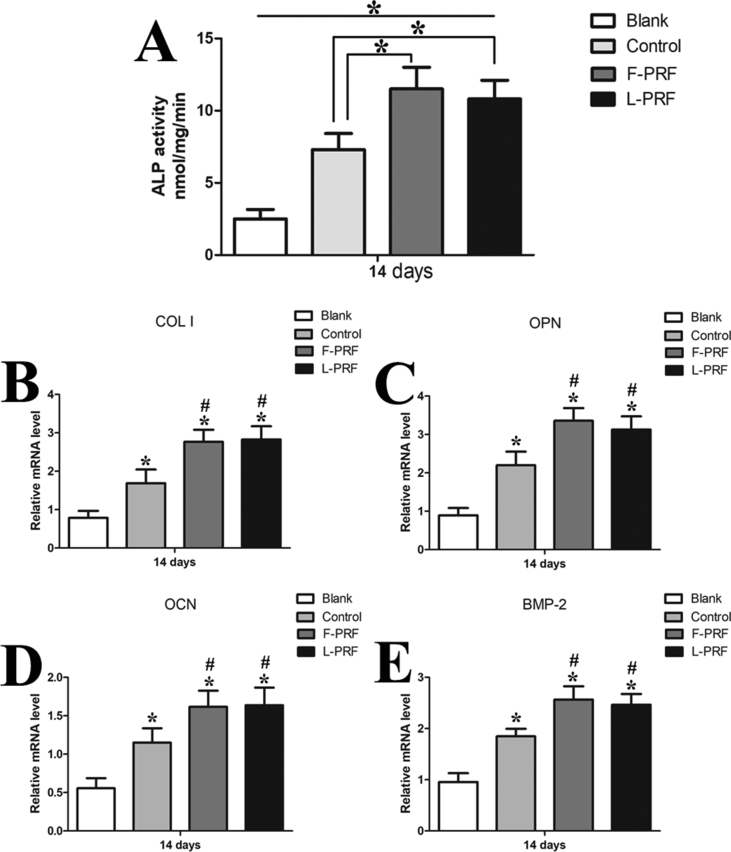
The effects of L-PRF on the osteogenic capacity of BMSC sheets. (A) The ALP activity in the blank group was significantly less than that that of the control and PRF groups at day 14 (P = 0.01). Moreover, the ALP activity in the L-PRF and F-PRF groups was notably greater than that observed in the control group (P < 0.05). However, there was no significant difference in the ALP activity between the F-PRF and L-PRF groups (P = 0.15). (B–E) Gene expression was analyzed by RT-PCR. Among all the groups, the blank control had the lowest relative gene expression levels for COL I, OPN, OCN, and BMP-2, which were significantly less than those observed in the control and PRF groups (P = 0.01). The relative gene expression levels of COL I, OPN, OCN, and BMP-2 were all highly upregulated in the L-PRF and F-PRF groups compared with that observed in the control group (P = 0.01). There were no significant differences in the relative levels of gene expression for these osteogenic markers between the F-PRF and L-PRF groups (P > 0.05). * Indicates a significant difference compared to the blank group (P < 0.05). # Indicates a significant difference compared to the control group (P < 0.05).